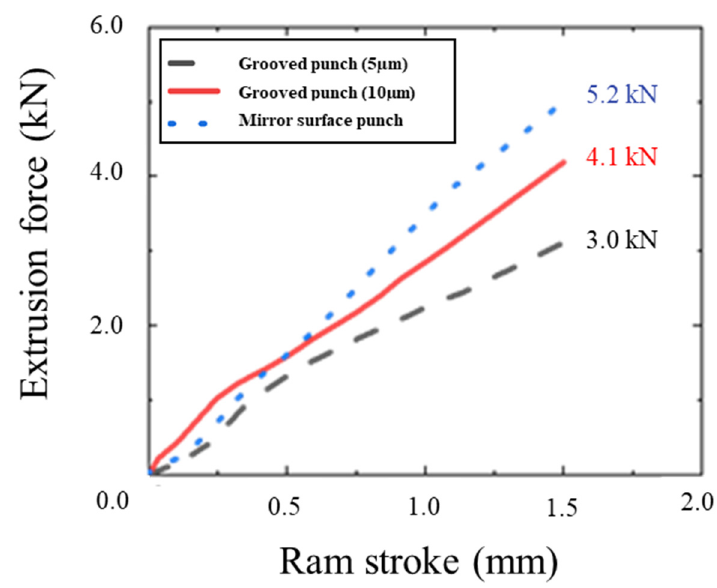
Figure 4. Extrusion force–ram stroke curve in each punch.